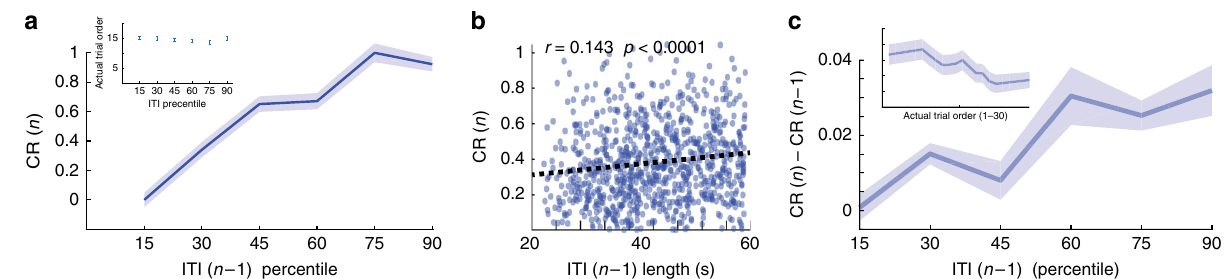
Fig. 2 Length of ITI contributes to learning rate. a The size of the CR in a trial ( n ) as a function of ITI duration in the previous trial ( n − 1), averaged across all sessions and binned into six percentiles (one-way ANOVA, signi fi cant effect for percentile, df = 5, f = 29.85, p < 0.0001). Inset shows the averaged trial order sorted similarly by ITI duration percentile ( n = 171, one-way ANOVA, df = 5, f = 0.74, p = 0.59). b Furthermore, CR size was positively correlated with the previous ITI duration (Spearman correlation, r = 0.14, p < 0.0001) on a trial-by-trial basis. c Change in CR amplitude between successive trials (CR in trial ( n ) minus CR in trial ( n − 1) increase with ITI duration (one-way ANOVA, df = 5, f = 81.14, p < 0.0001). ITI duration ( x -axis) computed similarly to a . For control, inset shows the standard expected learning effect i.e. the same change in CR ( n ) − CR ( n − 1) as a function of trials in learning. Data presented as mean ± S.E.M ( n days